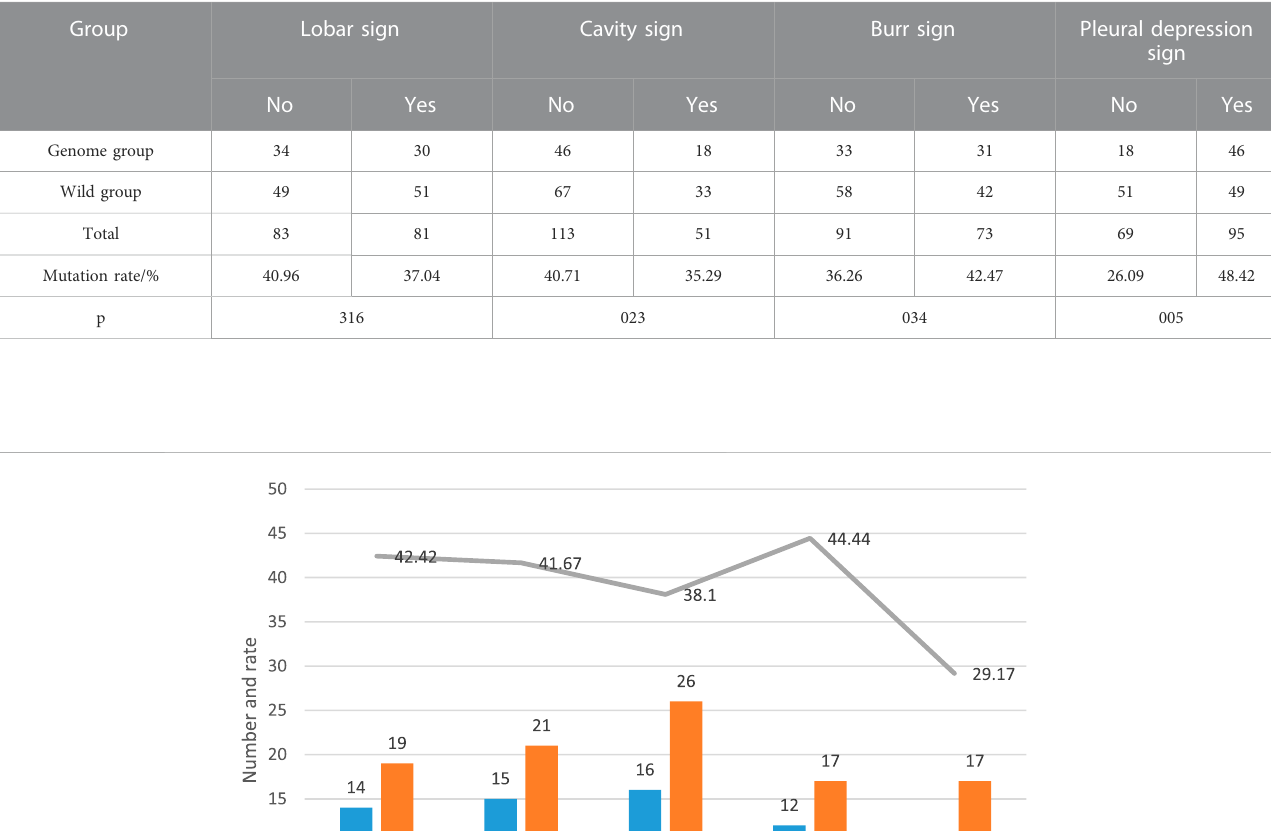
TABLE 3 Relationship between EGFR mutations and CT signs in LUAD lesions.